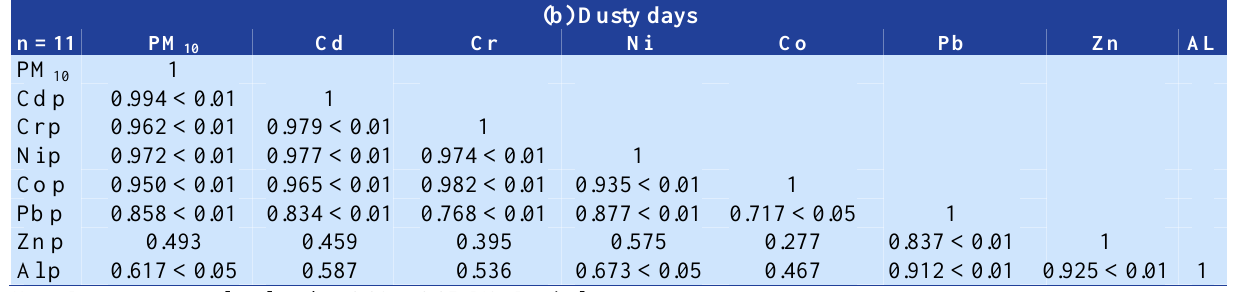
Table 3. Correlation coefficients between concentrations of PM10 and the heavy metals in PM 10 on normal and dusty days in the ambient air of Ahvaz, Iran (Continue) (b) Dusty